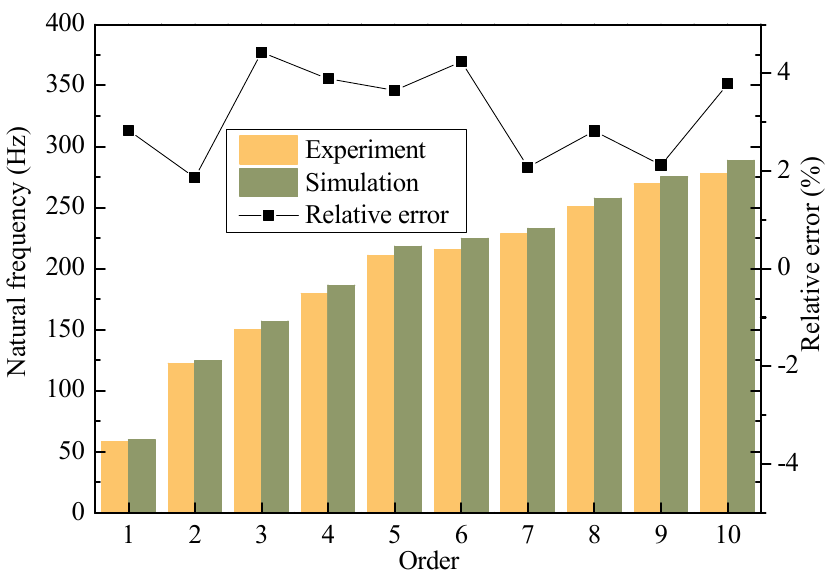
Figure 5. Because the maximum relative error was 4.4%, the accuracy of the block model was deemed acceptable and the vibro-acoustic calculation could be carried out [15].